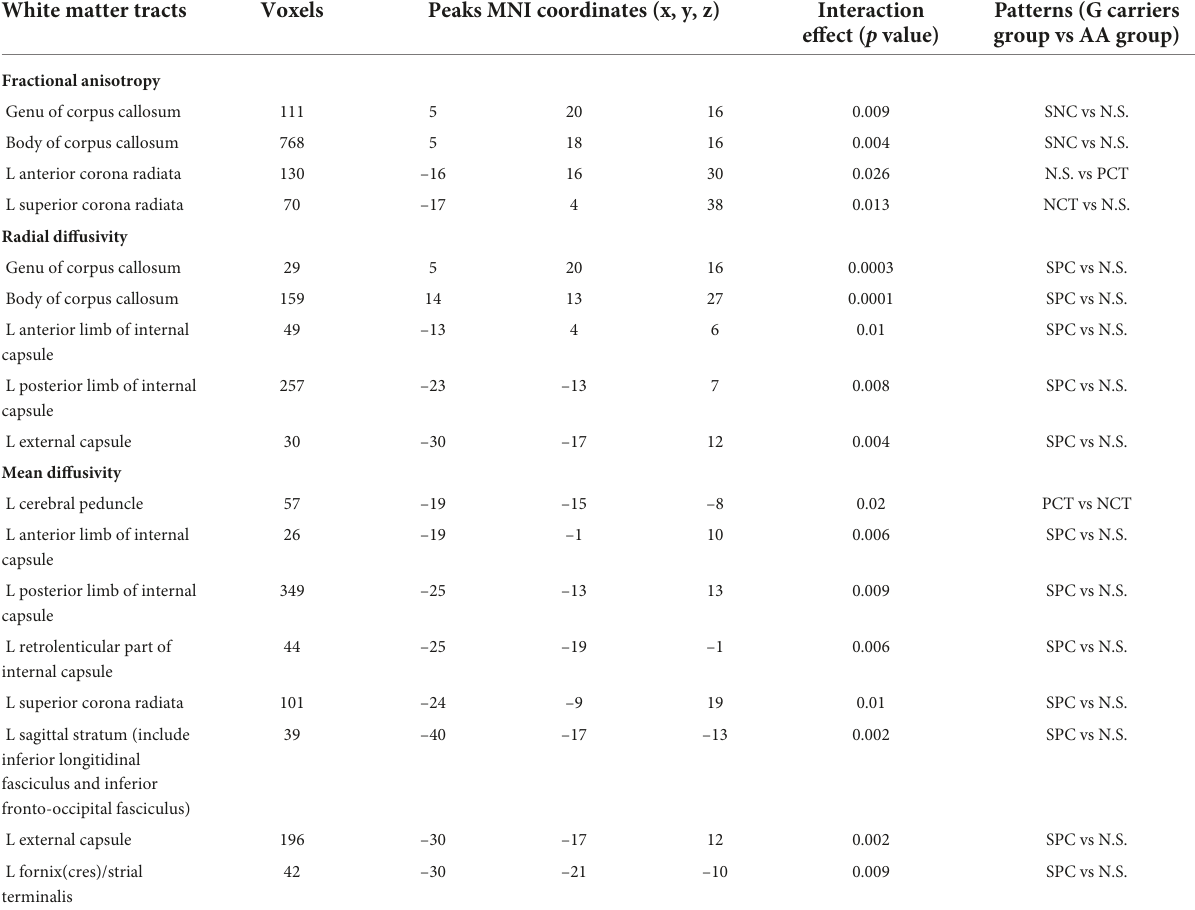
TABLE 3 Significant interaction effects between Per1 gene variants and BDI values in white matter microstructure. White matter tracts